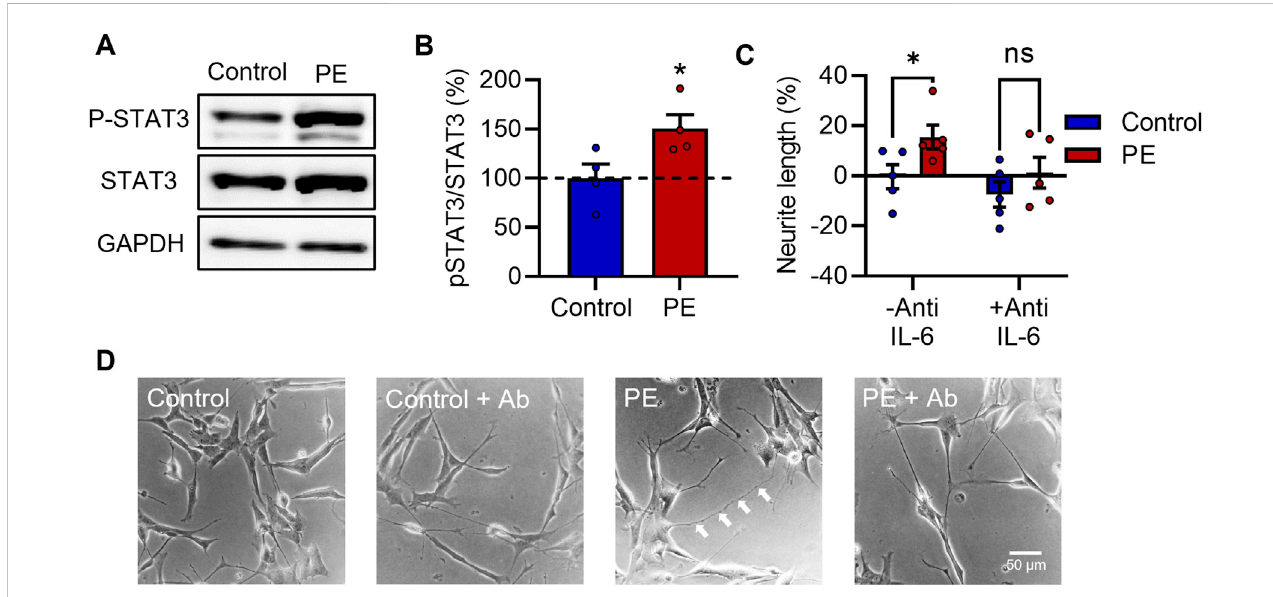
FIGURE 4 IL-6 signaling is stimulated in pre-eclampsia serum-treated RA-differentiated SH-SY5Y cells and is required for increased neurite growth. (A, B) Protein expression of p-Tyr 705 STAT3 relative to total STAT3 in RA-differentiated SH-SY5Y cells treated with 3% (v/v) serum for 24 h. (C, D) Graph and representative photomicrographs of neurite growth 72 h after serum treatment with or without an anti-IL-6 function-blocking antibody. Data are mean +SEM from four serum samples per group for B, or fi ve for C ( n = 4 – 5). (* p < 0.05 vs. control. Student ’ s unpaired t -test for B, 2-way ANOVA and post-hoc Fisher ’ s least signi fi cant difference (LSD) test for (C)